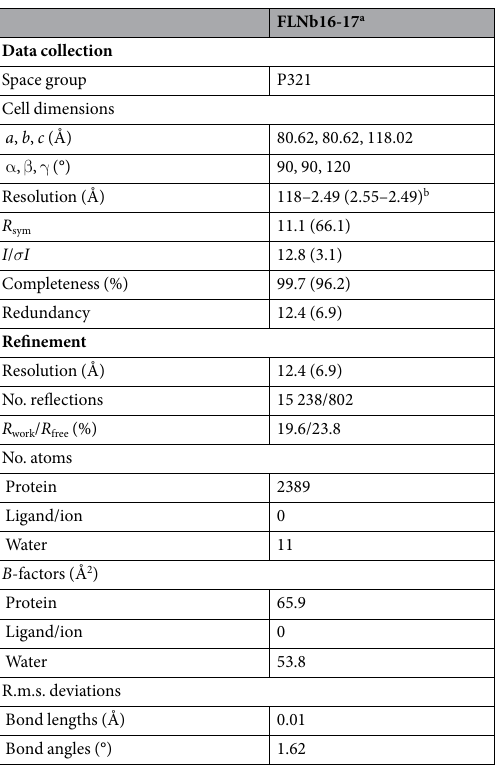
Table 1. Data collection and refinement statistics for FLNb16-17 crystal structure. a Diffraction data from a single crystal were used. b Values in parentheses are for highest-resolution